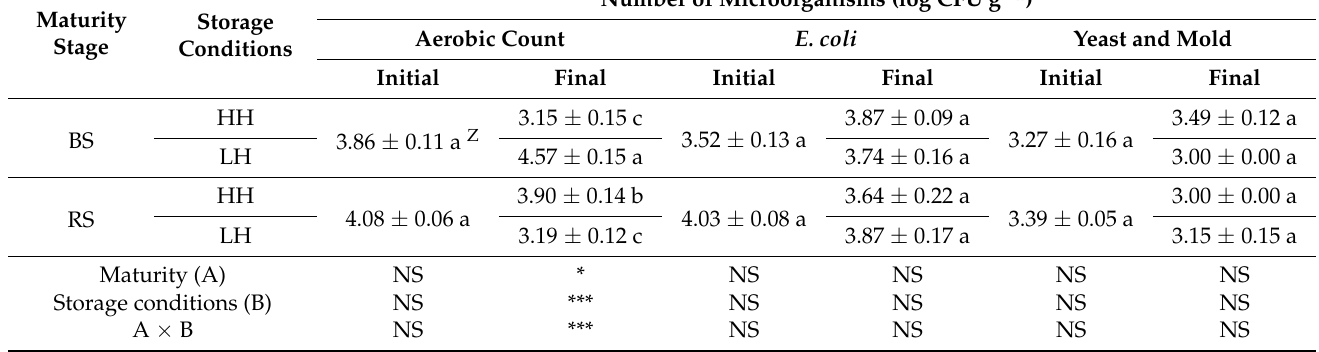
Table 4. High and low RH effects on the growth of microorganisms on sweet peppers before and on the final day after 15 days of cold storage at 5 ◦ C and 5 days at ambient